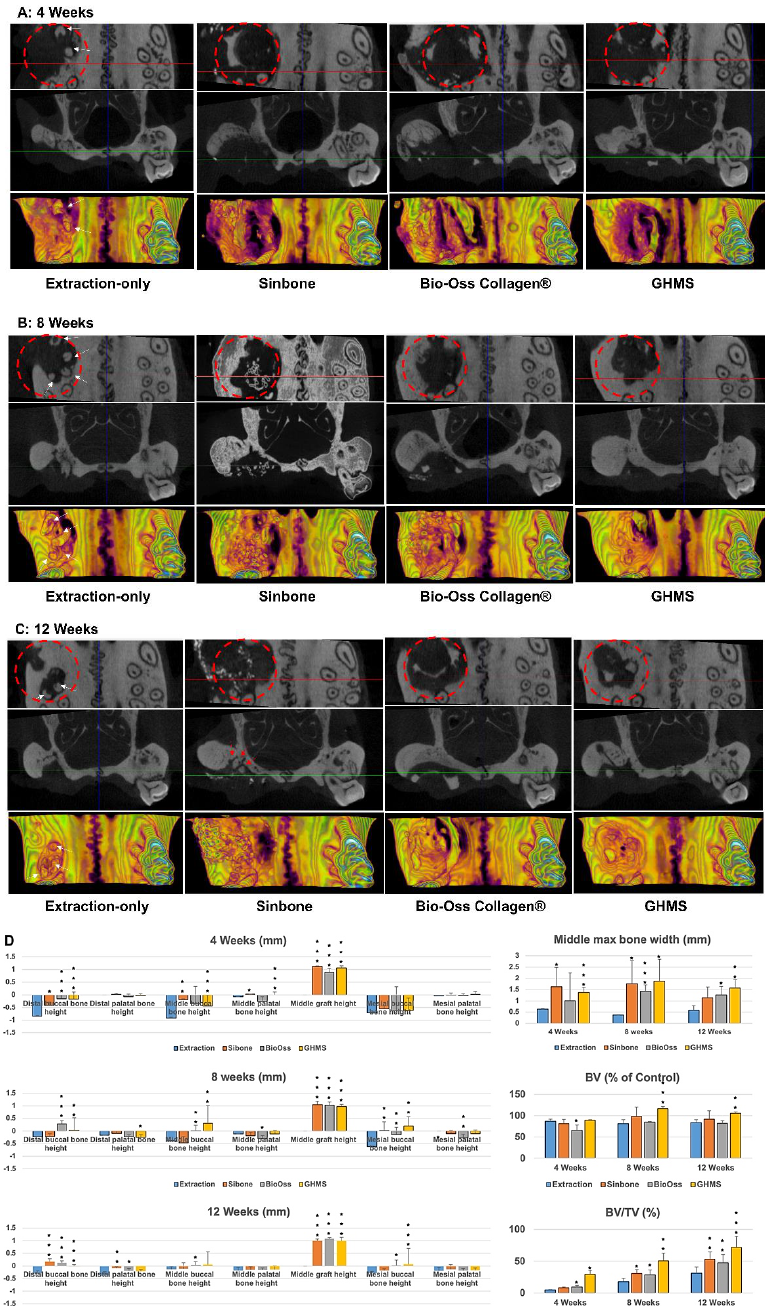
Figure 3. Comparison of the effectiveness of alveolar ridge bone regeneration at maxillary first molar (M1) examined by micro-computed tomography (micro-CT). Representative images show the coronal (top) and transaxial (middle) sections in the middle part of M1 site and the 3D occlusal view (bottom) of the extraction-only (without creating bone defect), Sinbone, Bio-Oss Collagen ® , and gelatin/nano-hydroxyapatite/metformin (GHMS) groups at ( A ) 4, ( B ) 8, and ( C ) 12 weeks. Please note that some root fragments remained in the extraction-only groups (white arrow). Substantial amount of residual grafting material at the defect site in the Sinbone group was evident after 12 weeks. ( D ) Analysis of bone heights, middle maximum bone width, bone volume (BV% of control), and bone fill (percentage of bone volume/total volume; BV/TV%) at different time points. (*: p < 0.05; **: p < 0.01; ***: p < 0.001).